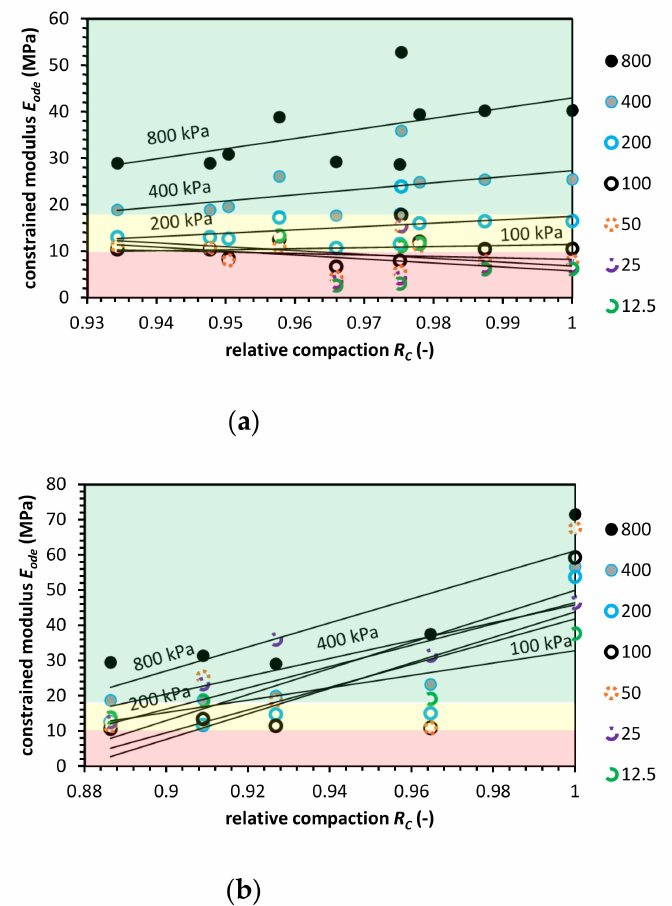
Figure 4. Constrained modulus value versus relative compaction value for recycled concrete ag- gregate (RCA) for ( a ) the Proctor compaction and ( b ) the Vibro compaction method. Colored areas mean required constrained modulus value, colors indication: green-zone of fulfilled E ode modulus requirement; yellow-moderate zone, where the constrained modulus is in the range of requirements; red-zone in which the E ode do not meet pipe fill